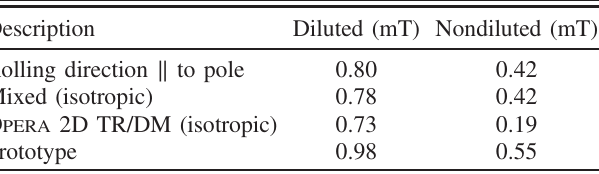
TABLE VI. Remanent field of the diluted and nondiluted magnet calculated with different